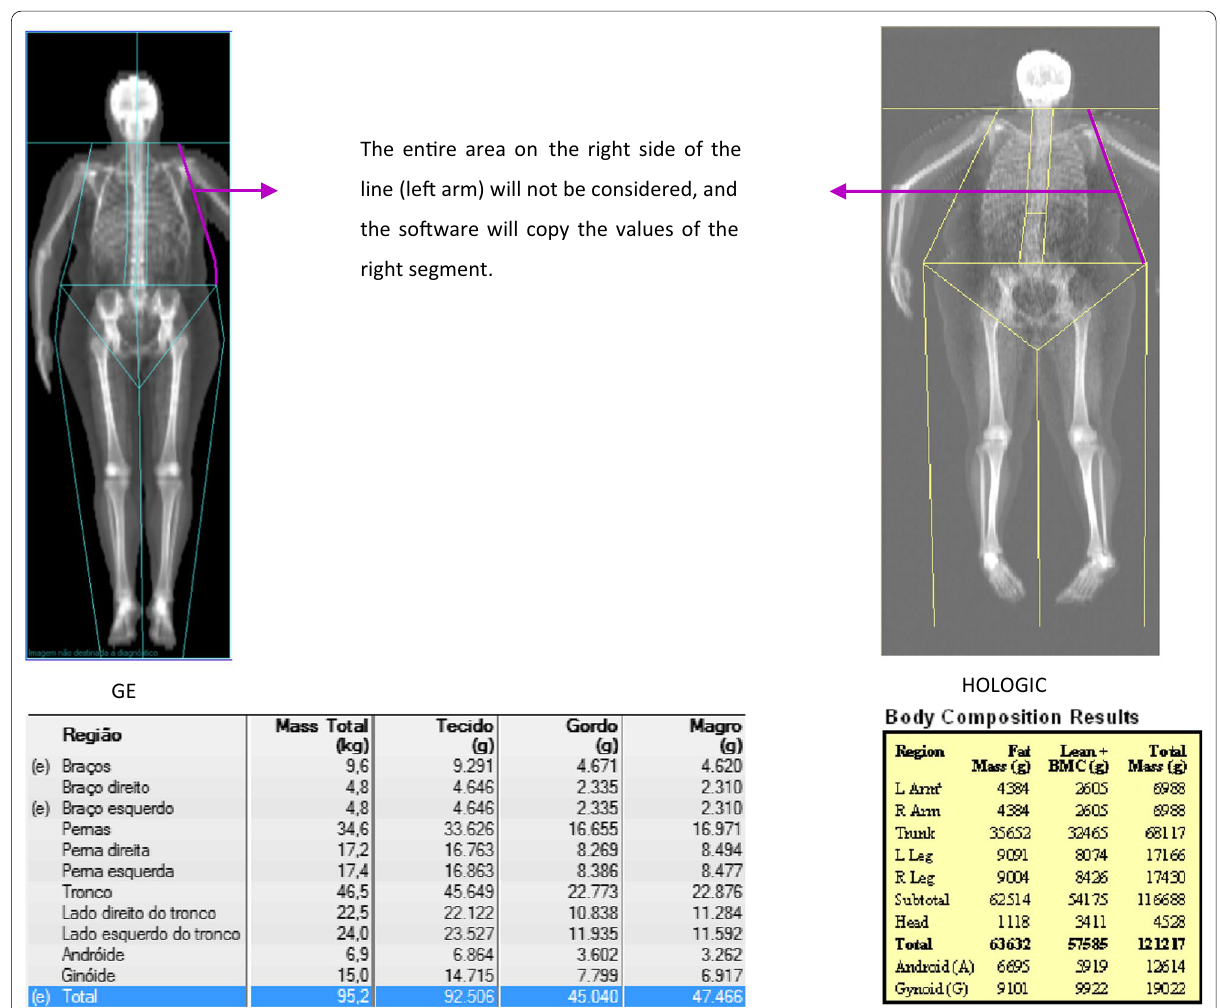
Fig. 10 Offset scanning in the GE‑Lunar and Hologic